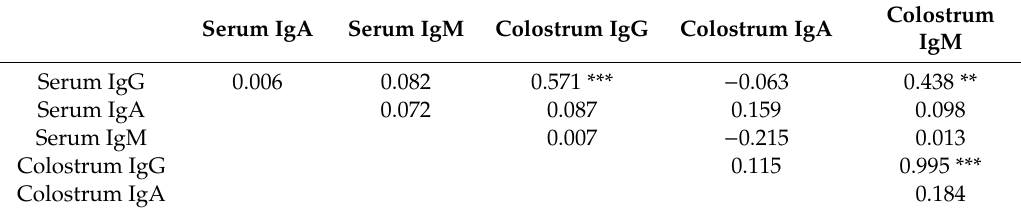
Table 5. Correlation coe ffi cients between serum and colostrum immunoglobulin (IgA, IgG and IgM) content of sows 1